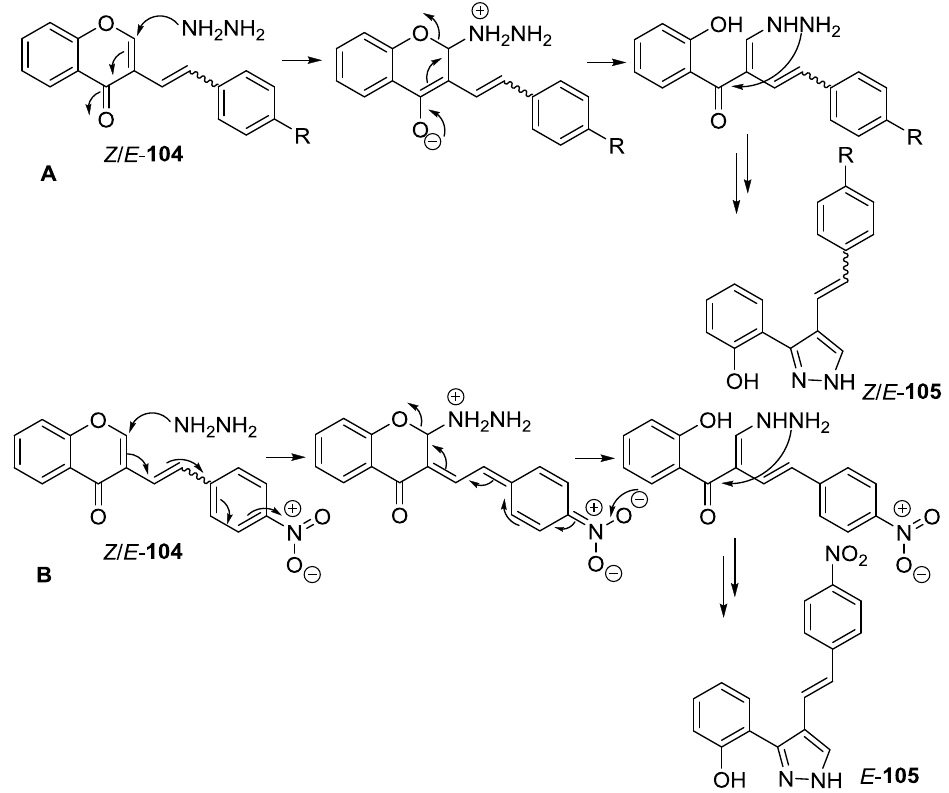
Generic mechanism proposed for the synthesis